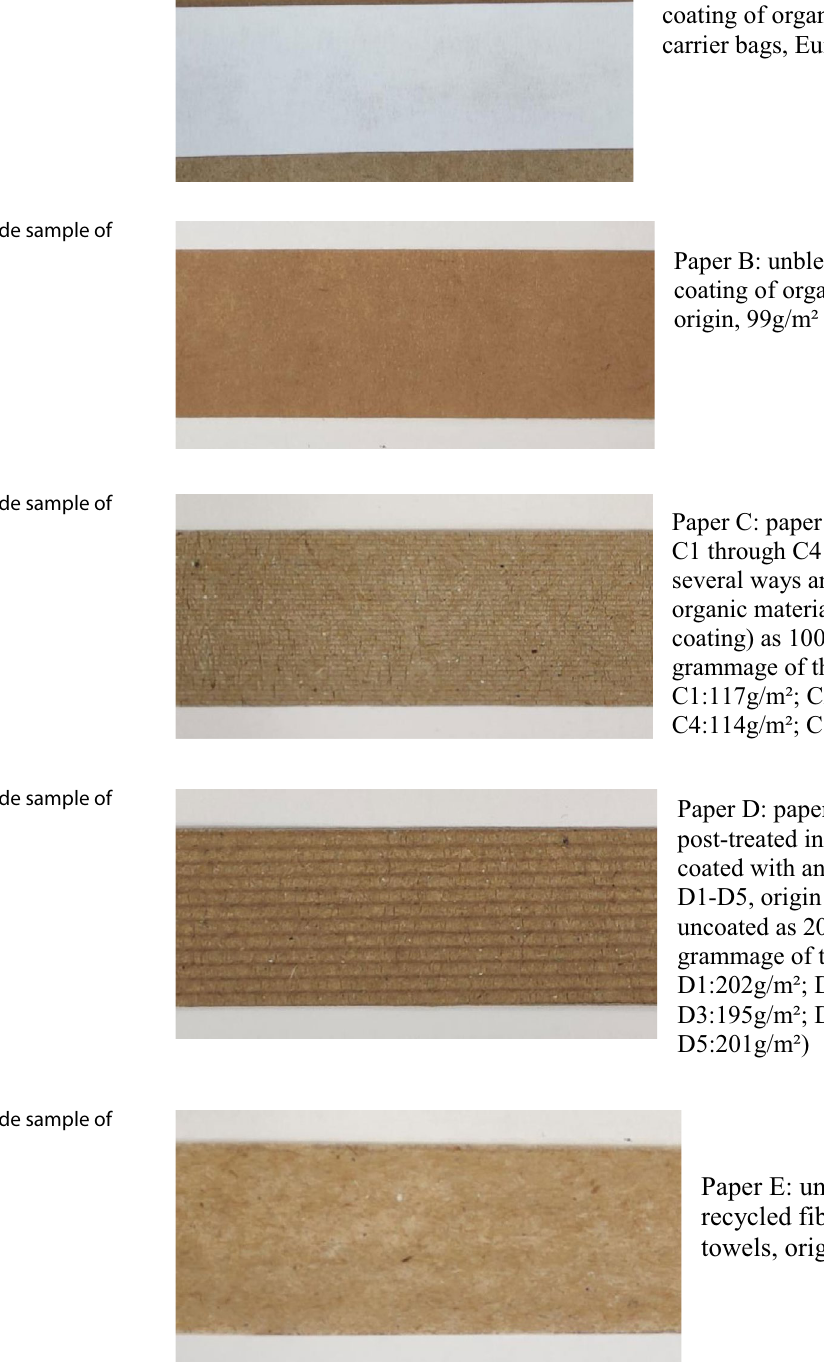
Paper A: bleached kraft paper with a